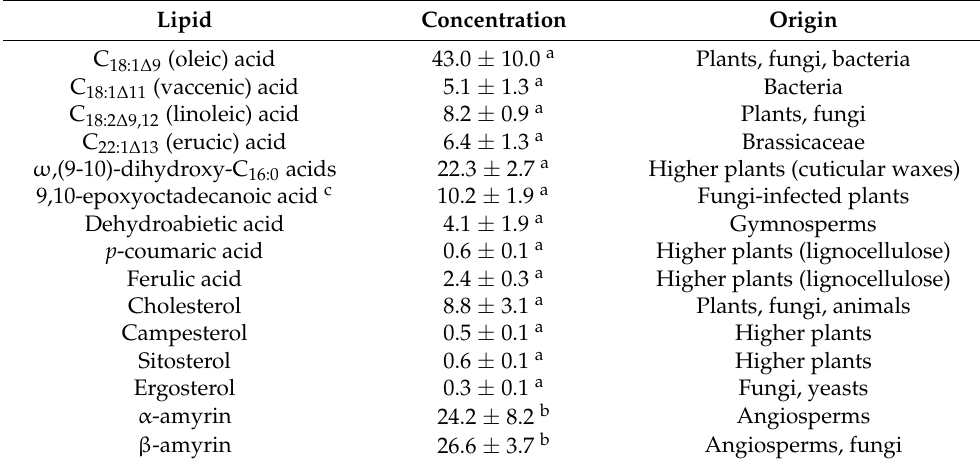
Table 1. Concentrations and origins of the lipid components of Negev loess deposits. Lipid Concentration Origin C 18:1 ∆ 9 (oleic) acid 43.0 ± 10.0 a Plants, fungi,